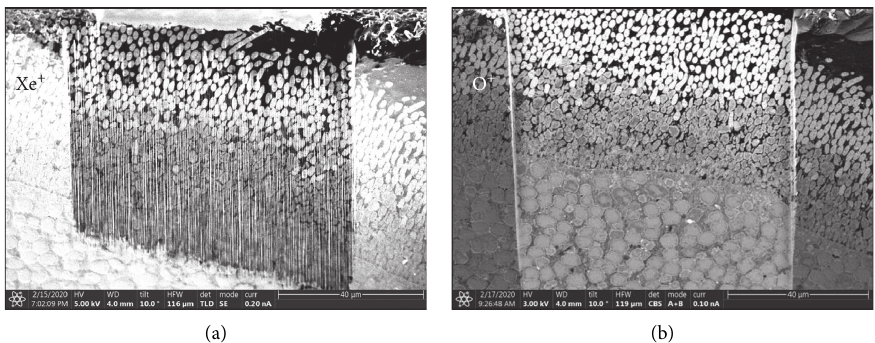
Figure 10: Example of superior cross-sectioning performance of O + vs. Xe + on biological